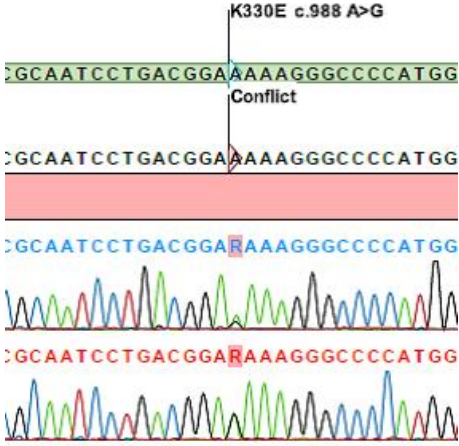
Figure 2. Sequence showing the identified PLG K330E mutation.